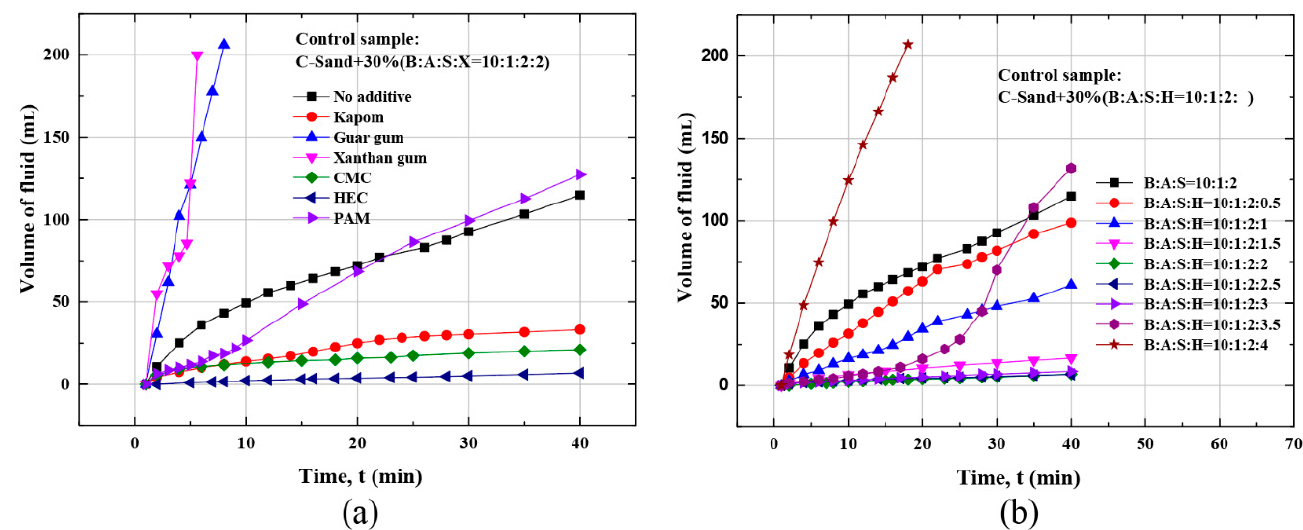
Figure 8. ( a ) Effect of high polymer types on B/A/S seepage flow. ( b ) Effect of HEC content on B/A/S seepage flow.